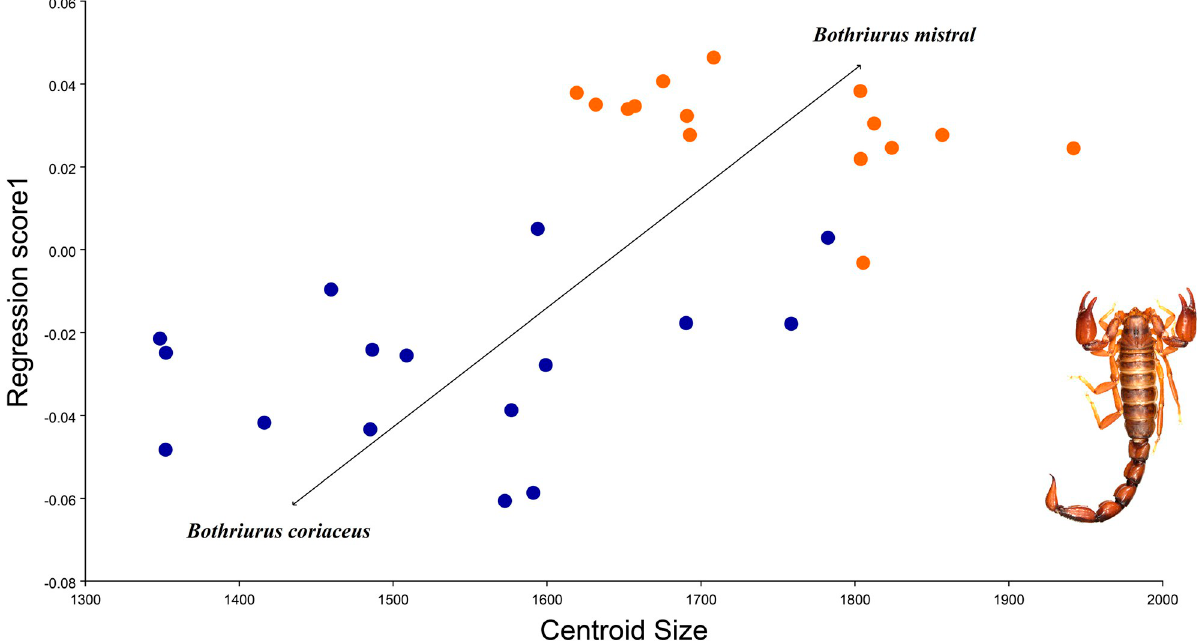
Fig 9. Multivariate regression of centroid size (independent variable) and shape (dependent variable) between B . coriaceus and B . mistral n. sp. The colors represent the different species (blue and orange